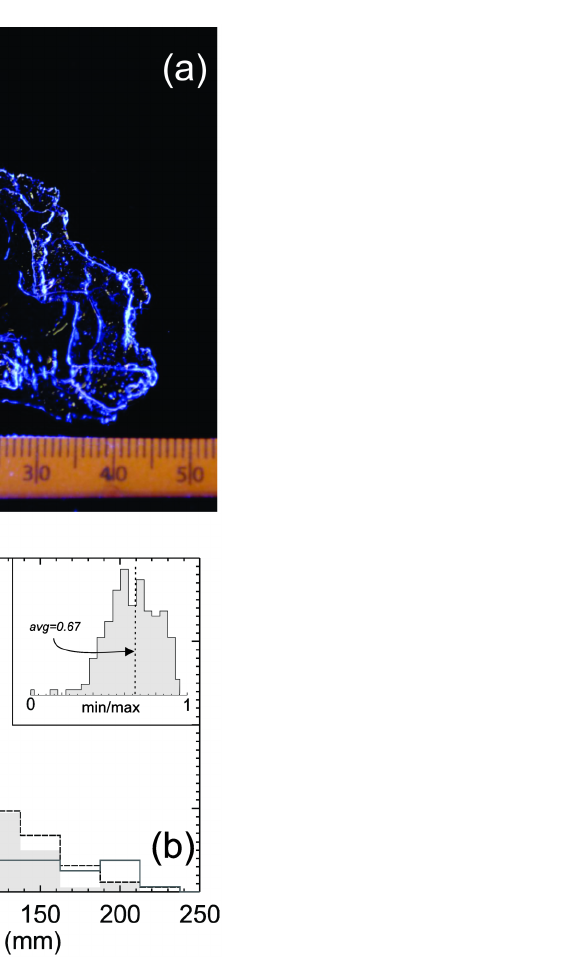
FIGURE 5 Crystal details including (A) an image of an example platelet (ruler in mm). (B) Scale distributions for 2015 (180 platelets) vector average of plan-view dimensions and the crystal thickness (scaled larger by a factor of 10) and 2016 (864 platelets, vector average of plan view dimensions). The ratio of the minimum to maximum side dimensions (i.e. not thickness) is shown as an